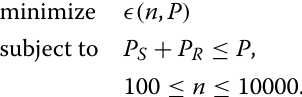
and (ii) OPA: P S + P R ≤ P . The choices of the mini-